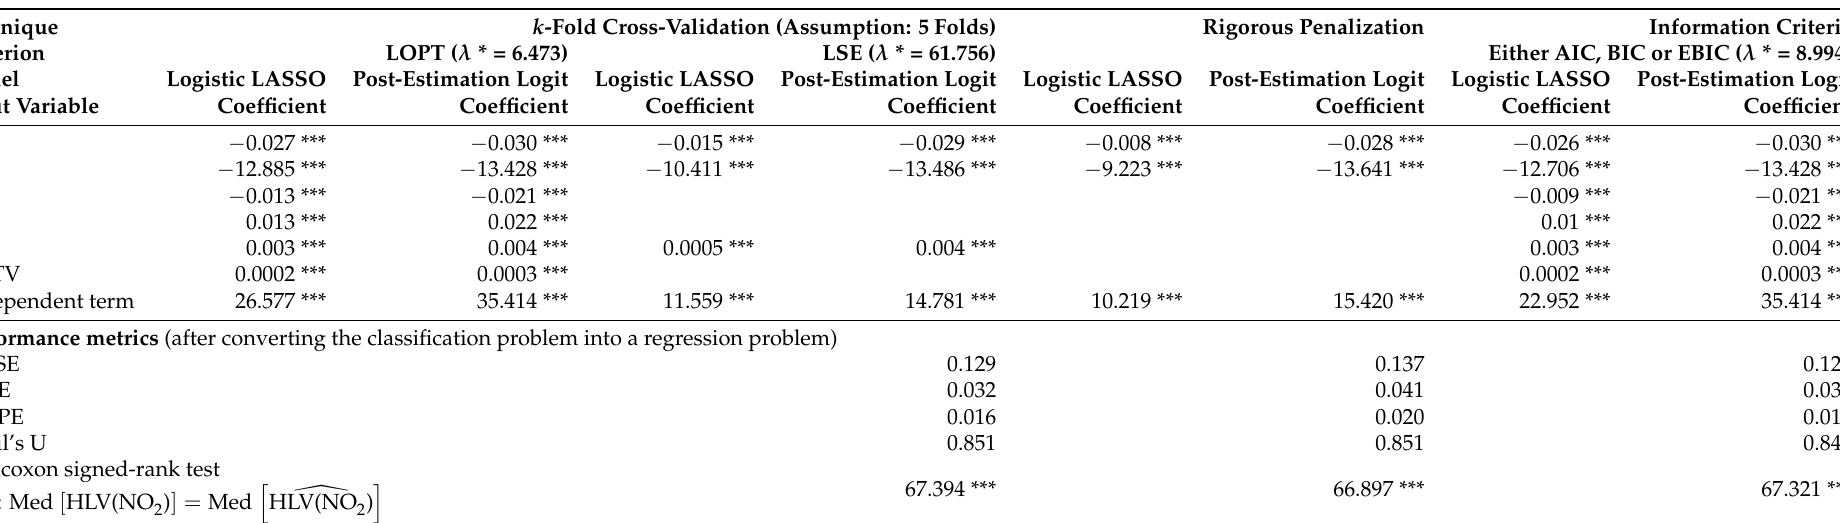
Table 6. Outcomes considering three regularization techniques combined with Logistic